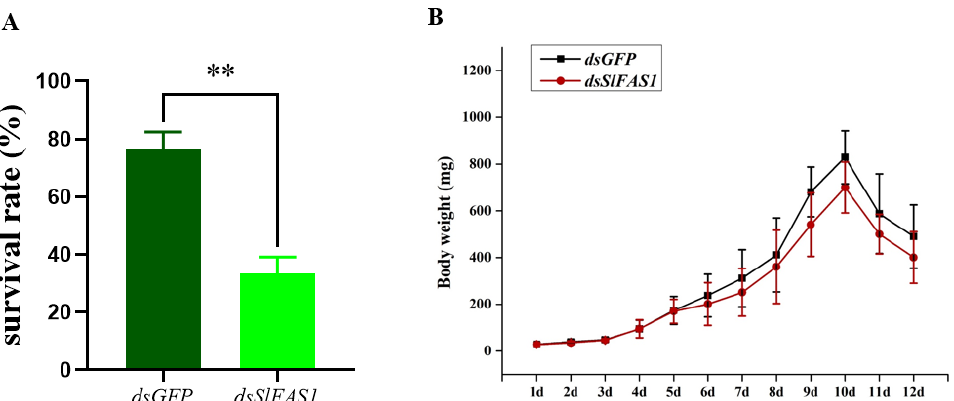
Figure 7. Effect of SlFAS1 on the development of S. litura larvae. ( A ) Survival rate of S. litura larvae after injection of dsSlFAS1 into third instar larvae. ( B ) Growth trajectory of S. litura larvae after injec- tion of dsSlFAS1 into the third instar larvae. Significant differences were compared using a one-way analysis of variance (ANOVA). Significant differences were indicated by asterisks (** p <